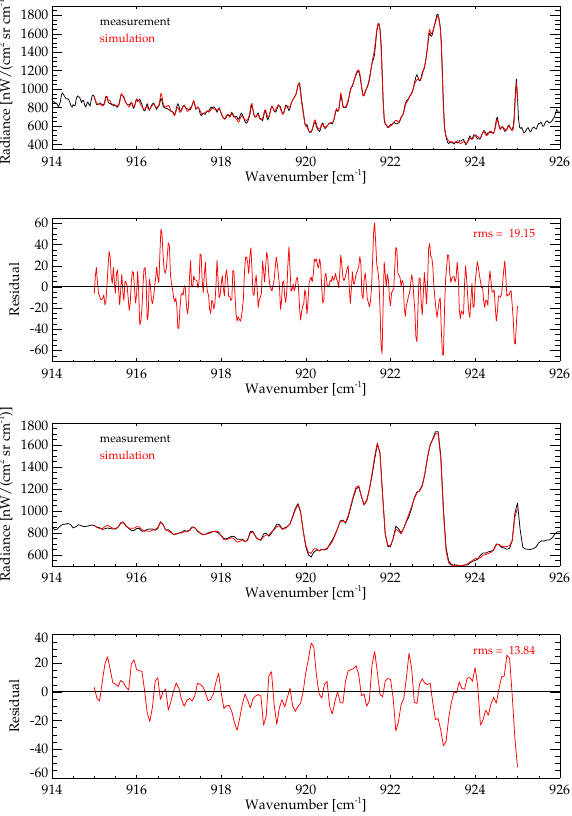
Fig. 4. Typical measured (black) and calculated (in red) spectra of CFC-12 and the fit residual in 11 km in the 915.0–925.0 cm − 1 spec- tral region for the FR (top) and the RR (bottom) spectral resolution nominal modes.